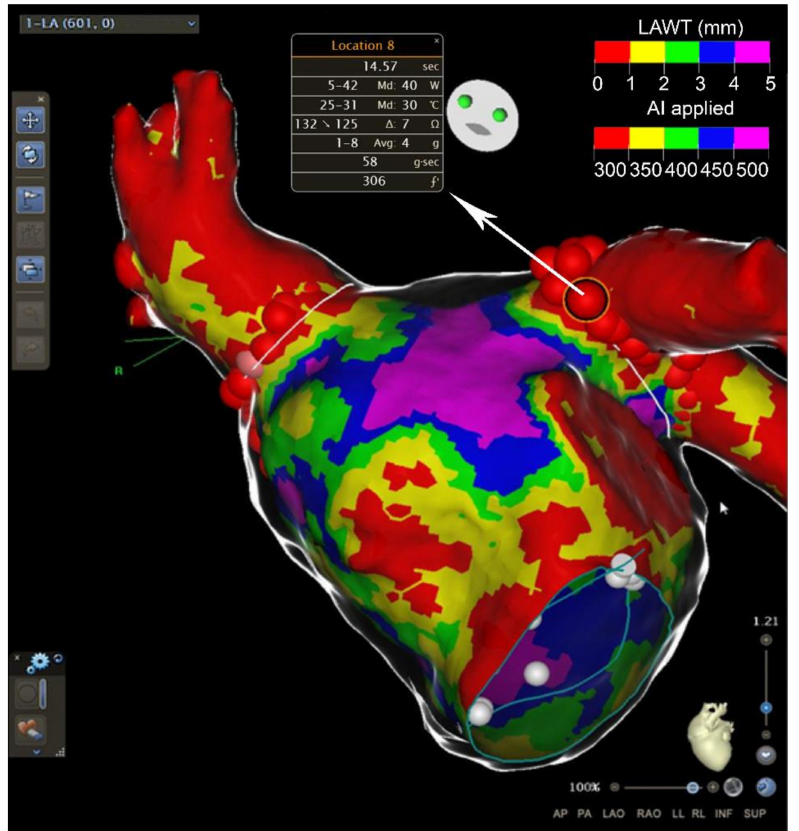
Figure 4. Usefulness of cardiac CT in atrial fibrillation ablation. Anterior view of the left atrium after atrial fibrillation ablation around the pulmonary veins. Atrial wall thickness (in mm) is depicted with different colors on the map. Major values in radiofrequency applications (AI) are used in thicker areas. AI = ablation index. LAWT = left atrial wall